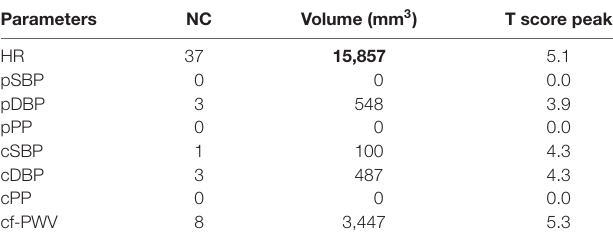
In bold: cumulative cluster volumes, considered as significant for influencing brain metabolism (>10 cm 3 ). HR, heart rate; pSBP, peripheral systolic blood pressure; pDBP, peripheral diastolic blood pressure; pPP, peripheral pulse pressure; cSBP, central systolic blood pressure; cDBP, central diastolic blood pressure; cPP, central pulse pressure; cf- PWV, carotid-femoral pulse wave